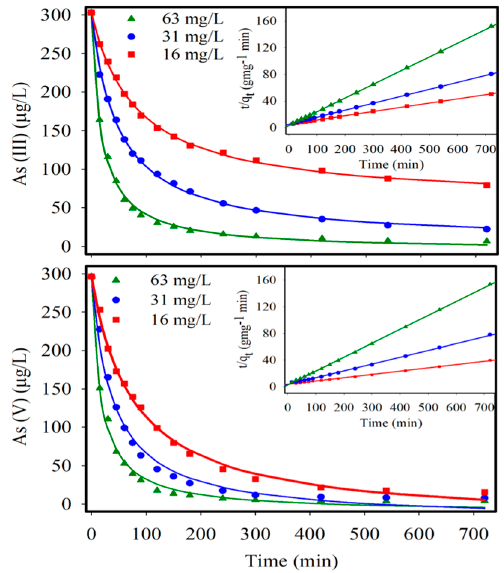
Figure 1. As(III) and As(V) adsorption kinetics with three different IONP loadings within CNF aerogel. The reported dosages are the IONP concentrations. The fitted aqueous arsenic concentrations were determined from the difference between the initial and adsorbed arsenic concentrations. The inset graphs are the pseudo second-order kinetic fits for the corresponding dosage of adsorbent according to Equation